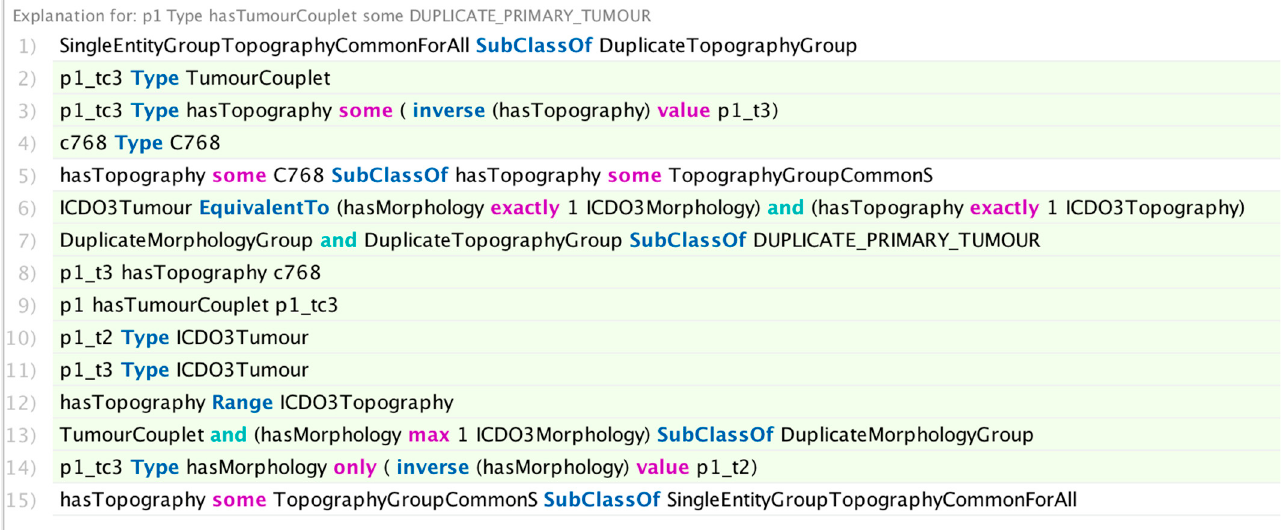
Figure 12. Explanation provided by the reasoner concerning why patient p1 has a tumour couplet that is a duplicate primary tumour.